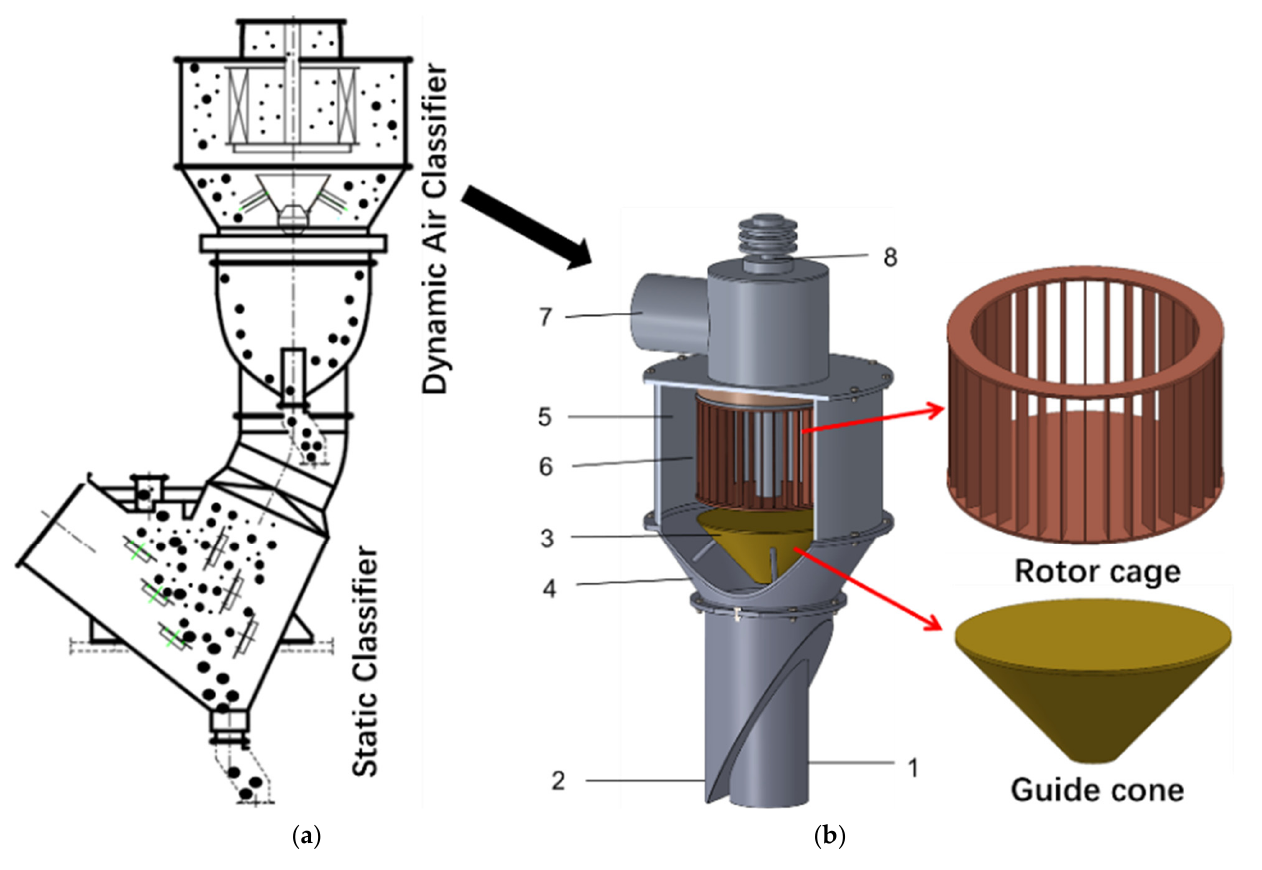
Figure 1. The three ‐ separation combined air classifier ( a ) and the 3D view of the dynamic air clas ‐ sifier ( b ): 1—air and material inlet, 2—coarse powder outlet, 3—guide cone, 4—cone area, 5—classifying chamber, 6—rotor cage, 7—air and fine powder outlet, 8—transmission shaft.